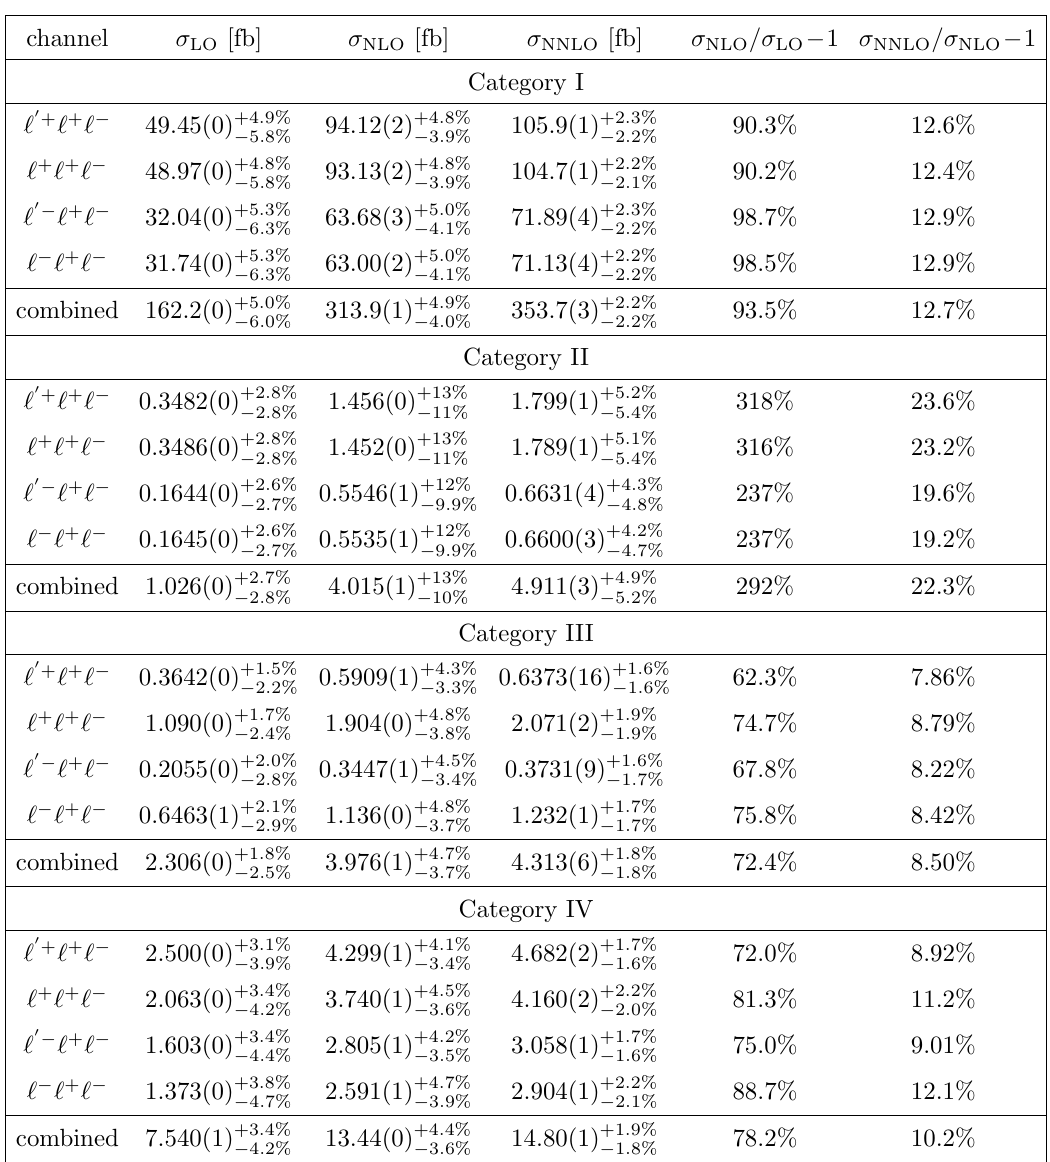
Table 6 . Fiducial cross sections at LO, NLO and NNLO for all three categories split by SF ( ‘‘‘ ) and DF ( ‘ 0 ‘‘ ) as well as W + Z and W (cid:0) Z production. The last two columns contain the relative NLO and NNLO corrections. \Combined" refers to the sum of all separate contributions.